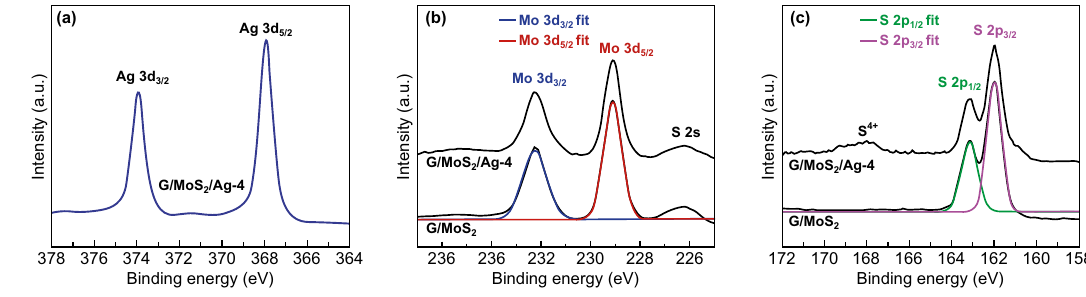
Fig. 3 XPS spectra of a Ag 3 d , b Mo 3 d , and c S 2 p core levels in G/MoS 2 and G/MoS 2